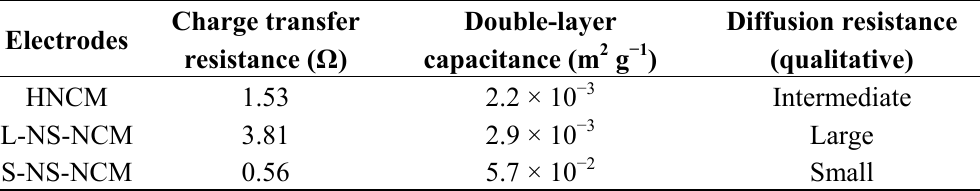
Table 2. Reaction resistances of HNCM, L-NS-NCM, and S-NS-NCM obtained by curve fitting with an equivalent